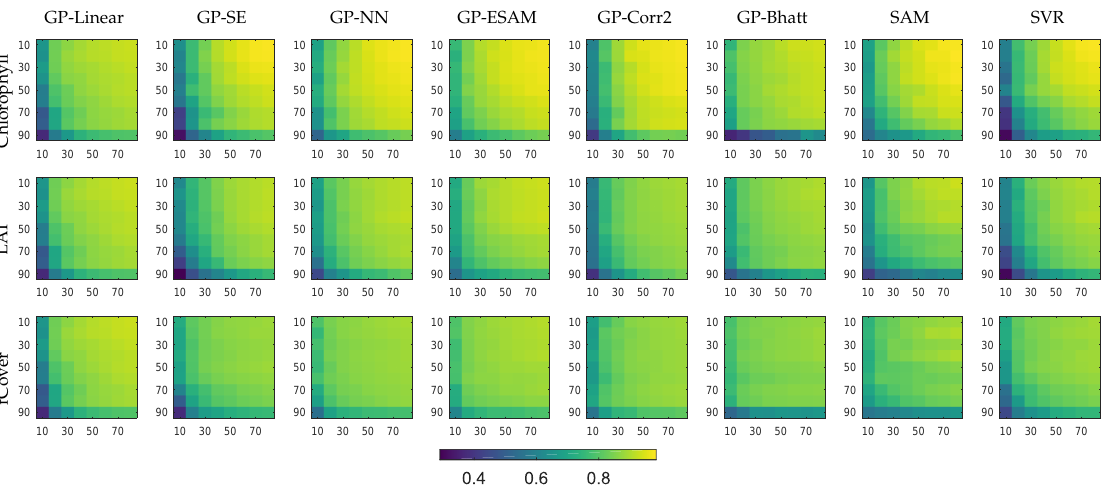
Figure 4. Mean predictive R 2 as function of training set size (x-axis) and illumination variations (y-axis) evaluated on simulated dataset. The x-axis of the plots is training set size and the y-axis of the plots is θ var